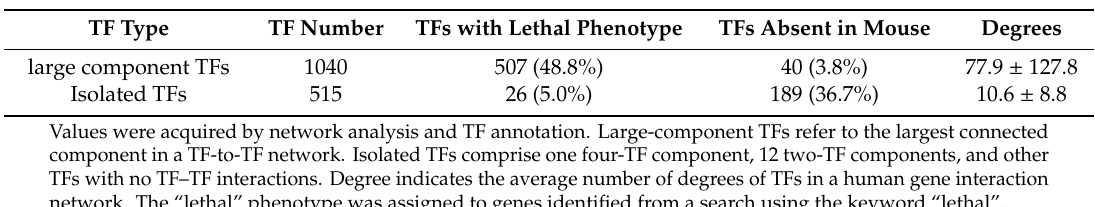
Table 1. Di ff erent features of large-component and isolated transcription factors